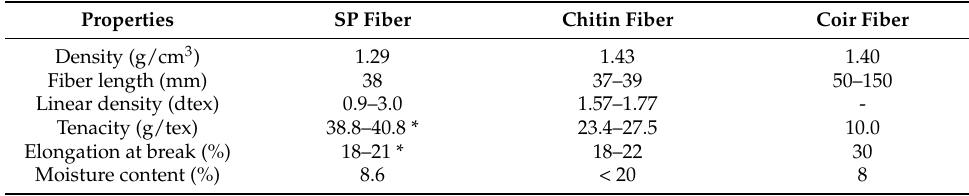
Table 1. Main physical properties of soy protein (SP), chitin, and coir